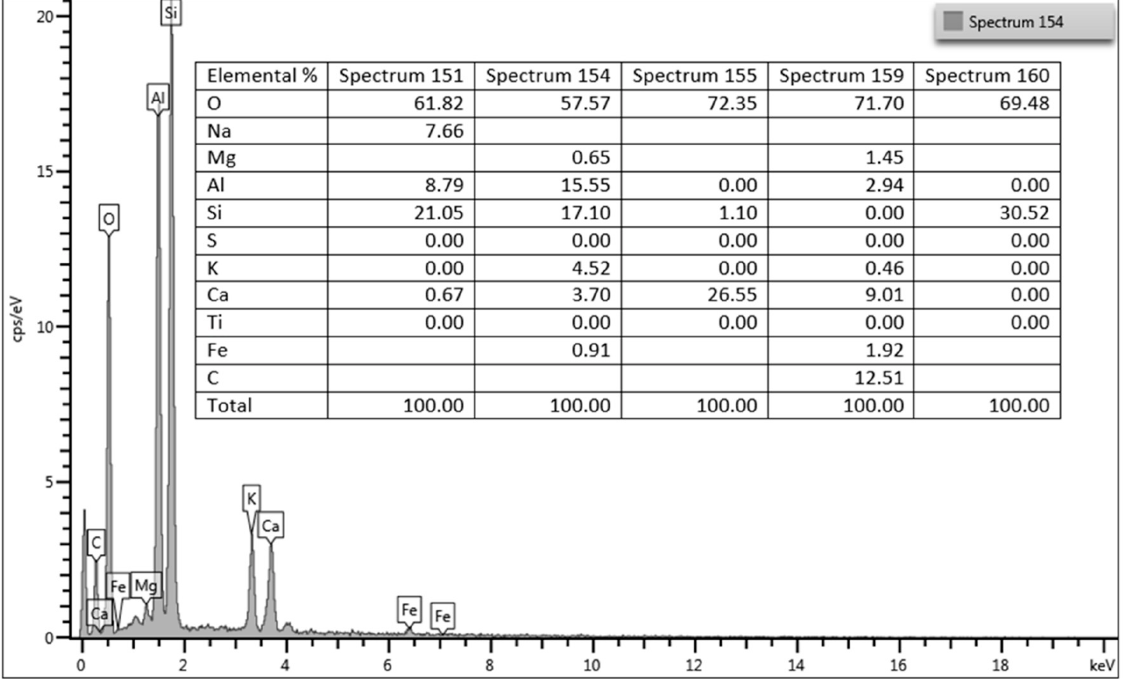
Figure A5. EDS analysis from the spectrum 154 of MFN mortar (the insert table is the % elemental composition of other spectrums).